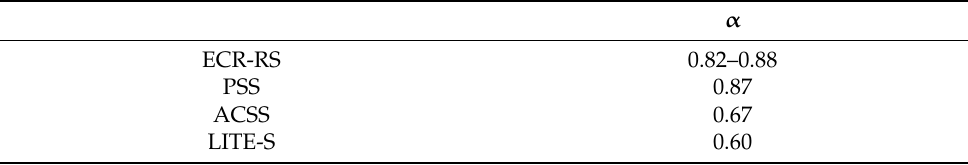
Table 1. Internal consistency of used